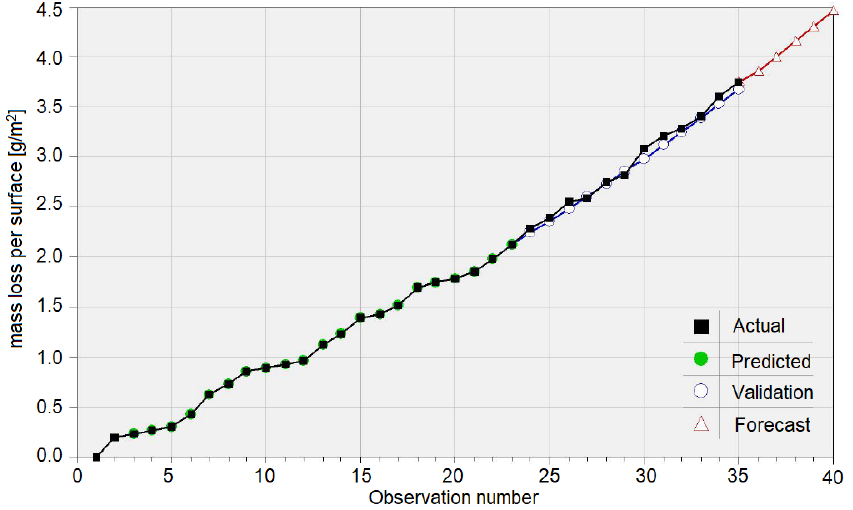
Figure 9. GRNN model with two regressors (lag 1 variable and time) for the mass loss per surface of the Cu sample.